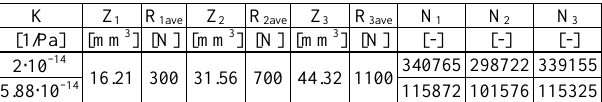
Table 2. Results of volumetric wear measurements of